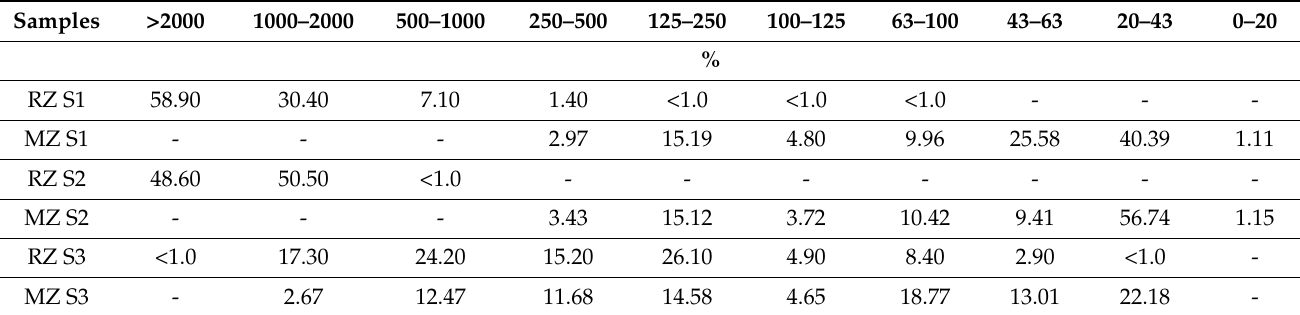
Table 3. Particles size distribution of RZ and MZ